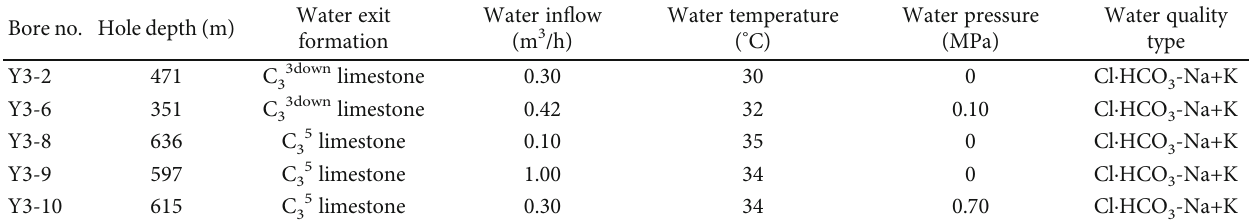
Table 1: Regional exploration and treatment e ff ect veri fi cation of outlet drilling. Bore no. Hole depth (m)